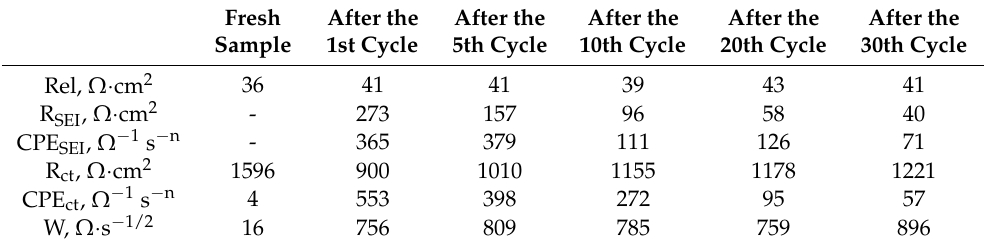
Table 2. Impedance spectra equivalent circuit element values after different CV cycles.